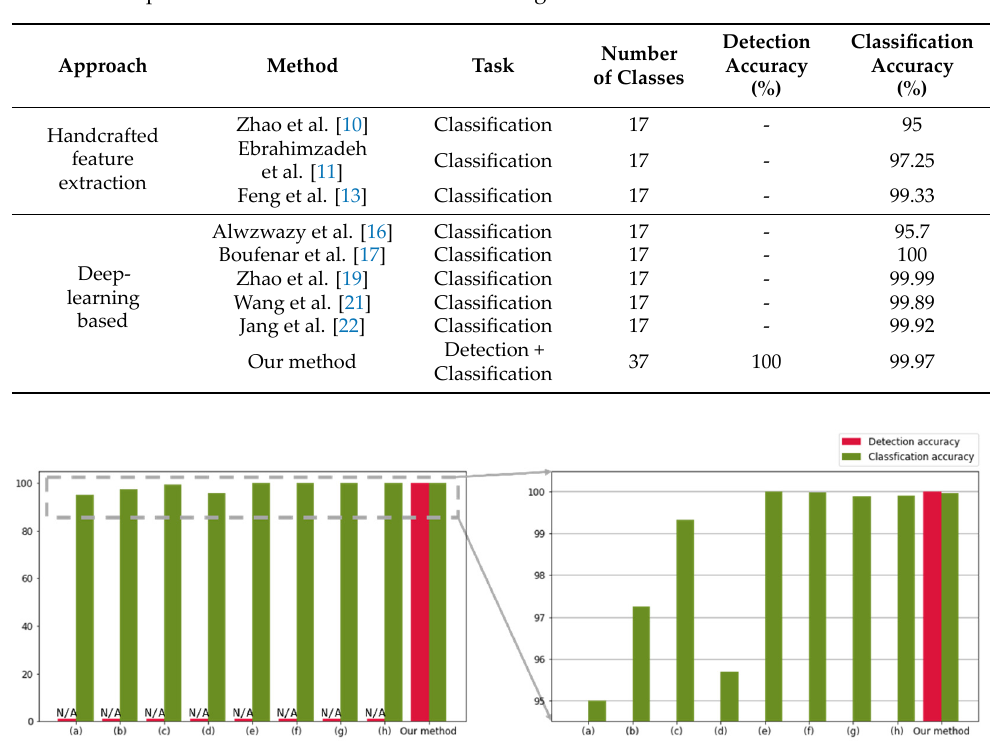
Table 5. Comparison of banknote serial number recognition methods.